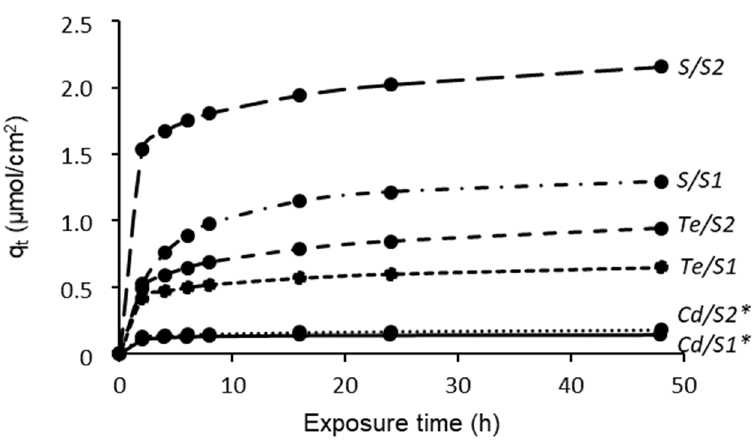
Figure 2. Plots for the sorption of cadmium, tellurium, and sulfur having particles. The pseudo second-order rate kinetic model and Elovich‘s equation have been applied to describe the feasibility of chalcogens having species and cadmium sorption onto PA 6, which fitted best the experimental results (minimum APE) (Table 3). The maximum adsorption capacity increased slightly as the concentration increases in all cases. The molar ratio of Cd:Te:S after 48 h of chalcogenization is 1:4.8:9.3 for 0.05 mol/dm 3 and, respectively, 1:5.3:11.9 for 0.1 mol/dm 3 initial precursor concentration. The adsorption rate constants, the initial adsorption rate, and the desorption constants were found to increase with decreased concentration of Te and Cd, except for S, where they decreased. Table 3. Model parameters for tellurium, sulfur, and cadmium species sorption kinetics by PA 6.